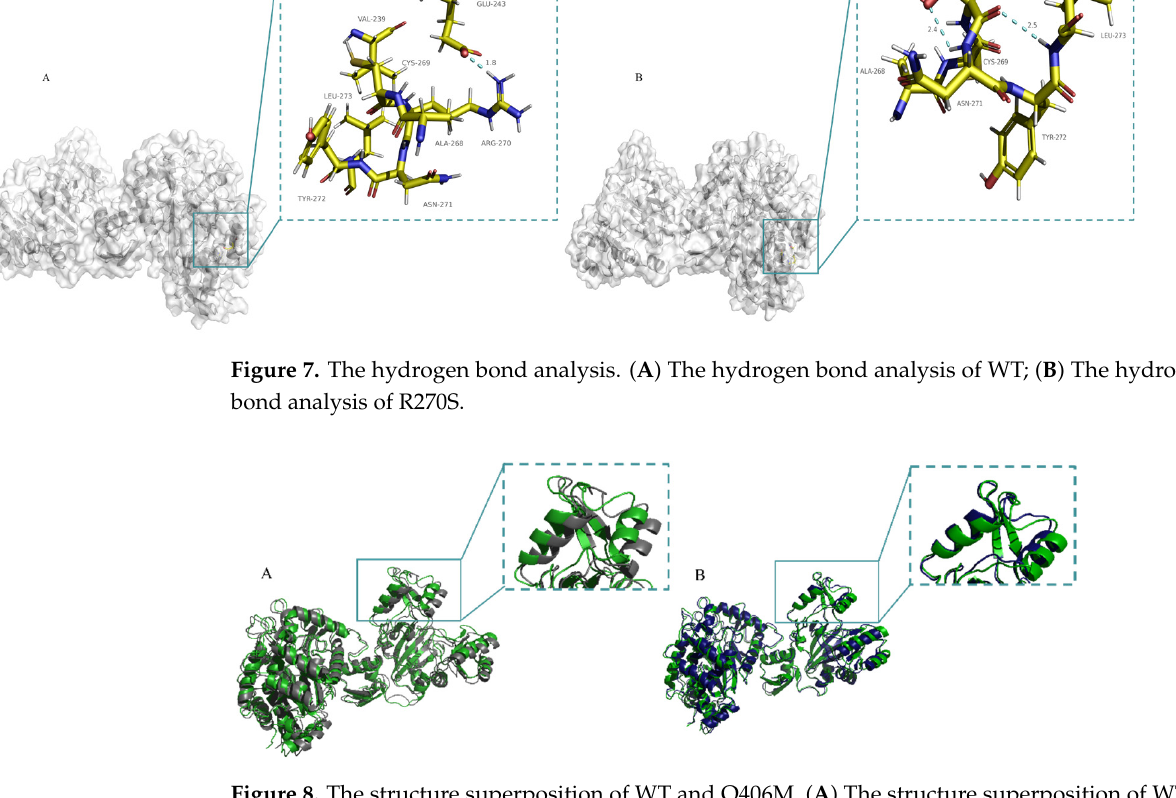
Figure 8. The structure superposition of WT and Q406M. ( A ) The structure superposition of WT at 298 K and WT at 313 K; ( B ) The structure superposition of Q406M at 298 K and Q406M at 313